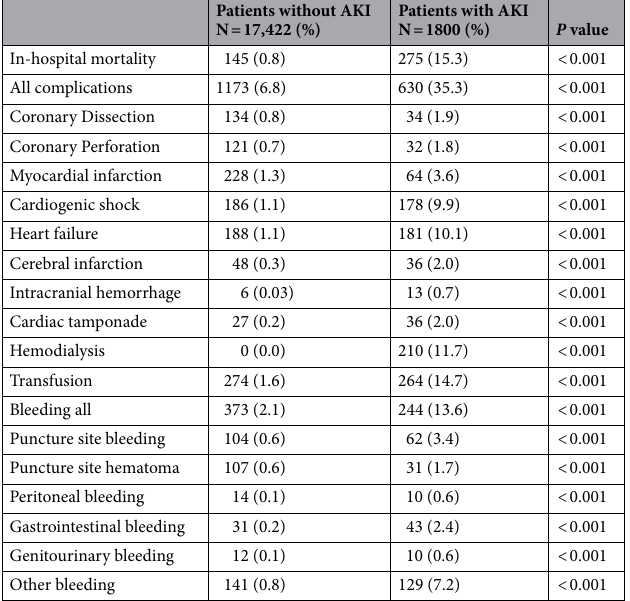
Table 2. in-hospital mortality and complications. AKI: Acute kidney injury.